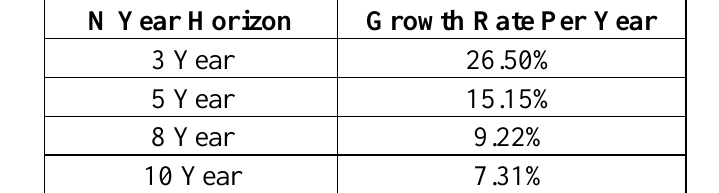
Table 7. Annualized Growth Rates for Restoration of the M1 Multiplier from 0.82 to 1.66 1 .